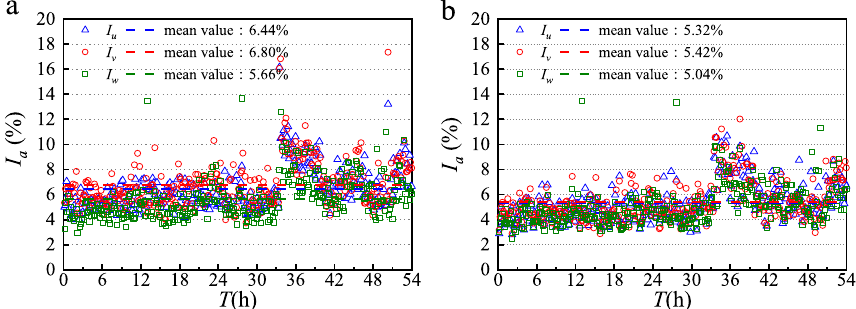
Fig. 5 Turbulence intensities during PSRB observation period: a Stationary model; b Non-stationary